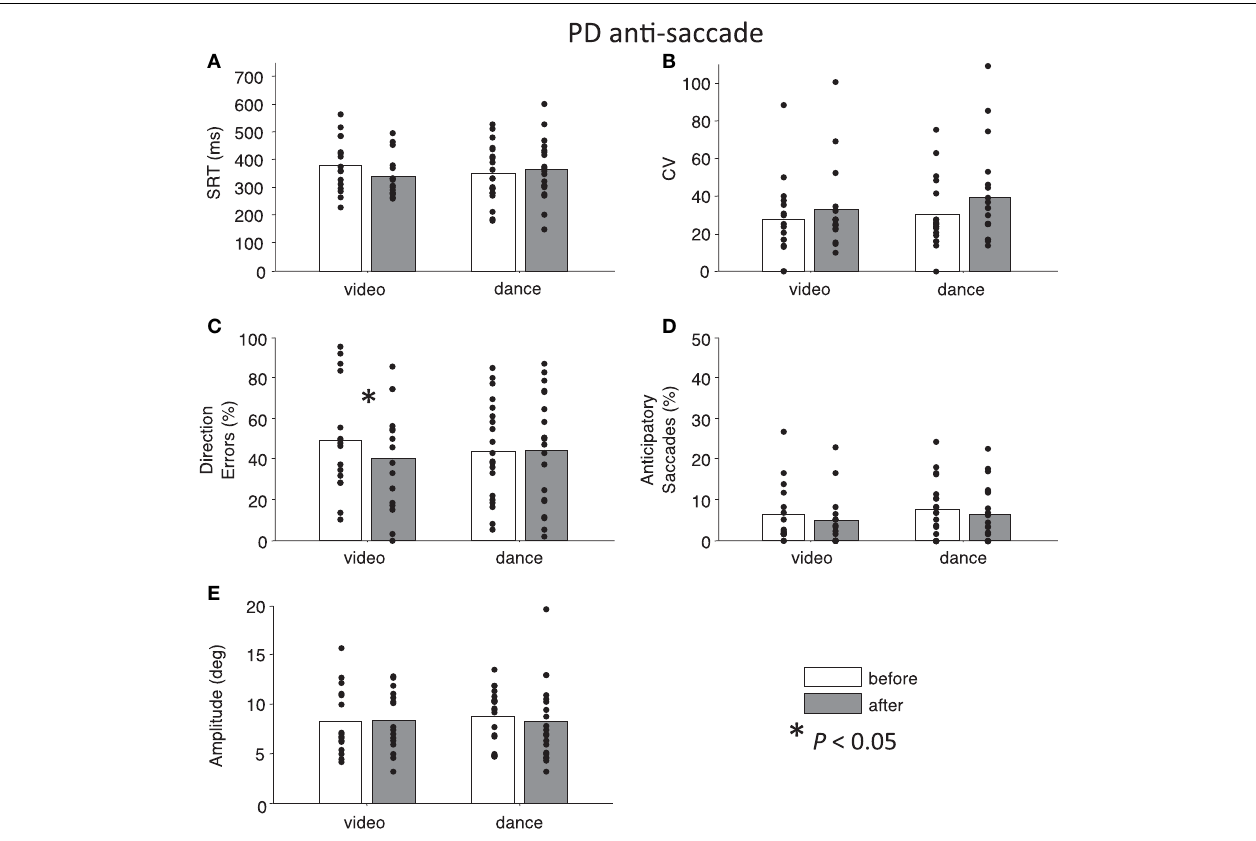
FIGURE 3 |Anti-saccade behavior in participants with PD. (A) Saccade reaction time (SRT). (B) Intra-subject coefficient of variability in saccade reaction time (CV). (C) Percentage direction errors. (D) Percentage anticipatory saccades. (E) Saccade